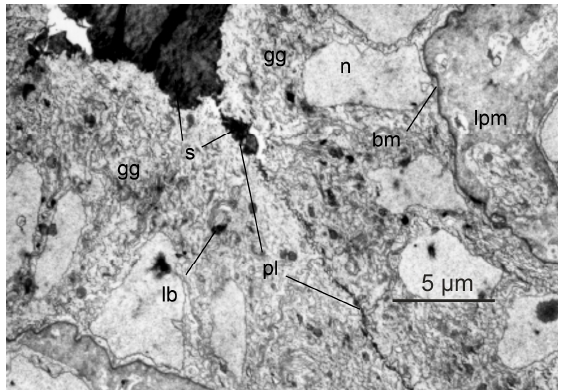
Figure 1. Histology of glass eel swimbladder. In Leptocephali developing into glass eels, the swimbladder initially is filled with surfactant; opposing gas gland cells appear to be separated by a thin layer of surfactant. Gas gland cells do not yet express an extensive basolateral labyrinth and the connection between gas gland cells and blood capillaries is not as tight as in yellow eels. gg, gas gland cell; s, surfactant; n, nucleus; pl, plasma membrane; lb, lamellar body; bm, basal membrane; lpm, lamina propria mucosae. Modified after